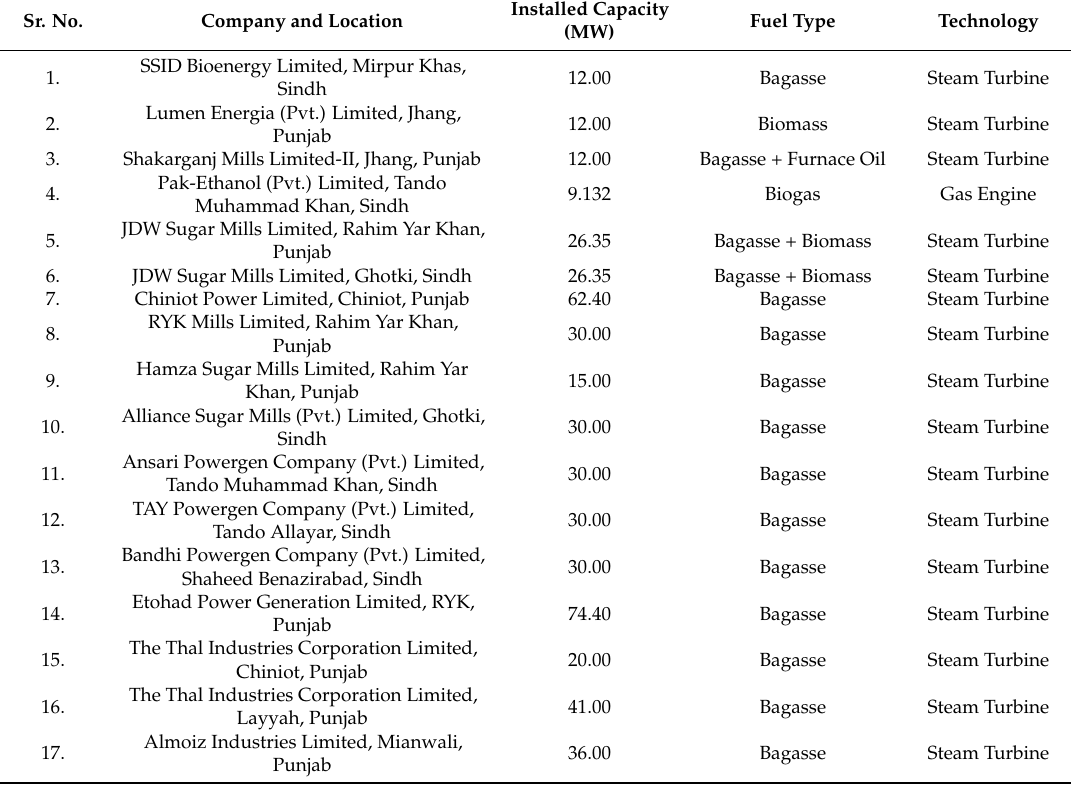
Table 21. List of generation licensees bagasse/biomass power projects under the renewable energy policy of